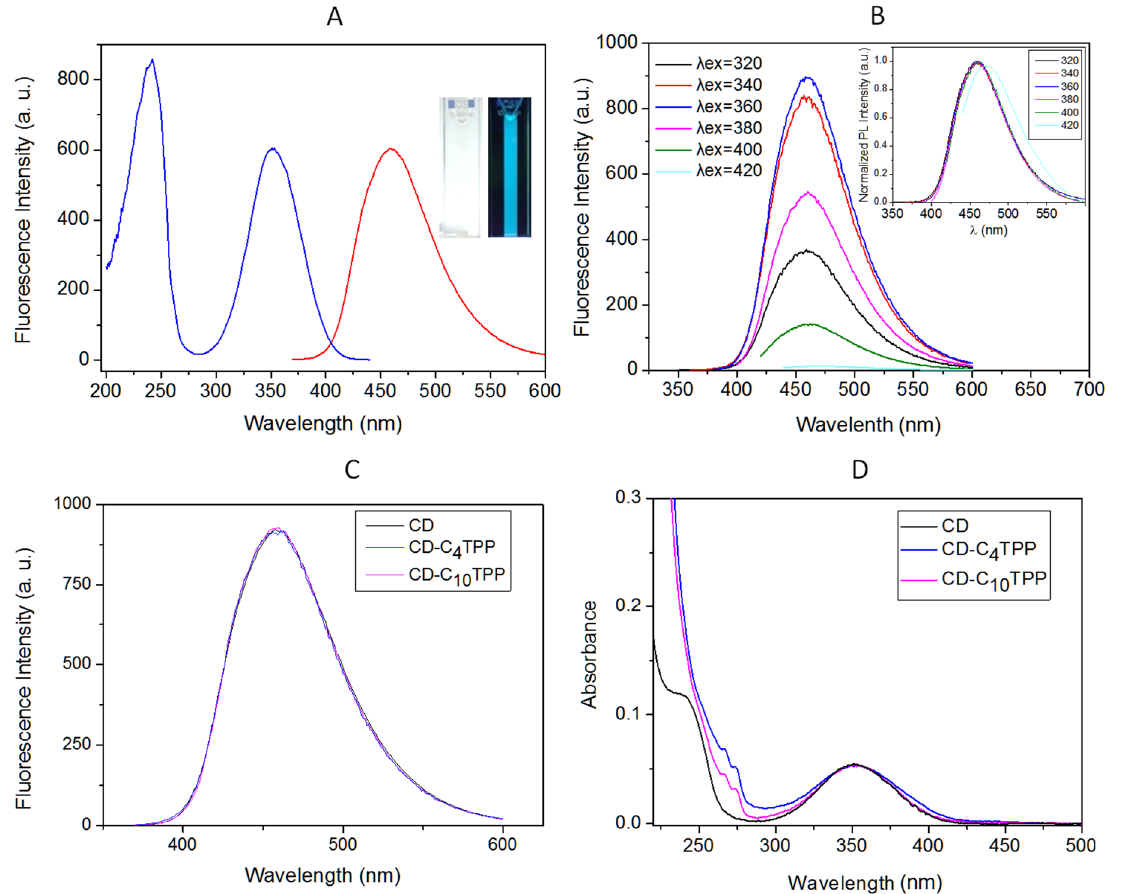
Figure 2. ( A ) Excitation (blue line) and emission spectra (red line, λ ex = 352 nm) of N-doped CDs in water. Inset: photographs of their solutions under ambient light (left) and under a 365 nm UV lamp (right). ( B ) Emission spectra at progressively increasing excitation wavelengths (320 nm–420 nm). Inset: the corresponding normalized emission spectra at various excitation wavelengths. ( C ) Emission spectra of CDs and of their alkyl-TPP derivatives ( λ ex = 352 nm). ( D ) Normalized UV–Vis spectra of CDs and of their alkyl-TPP derivatives.